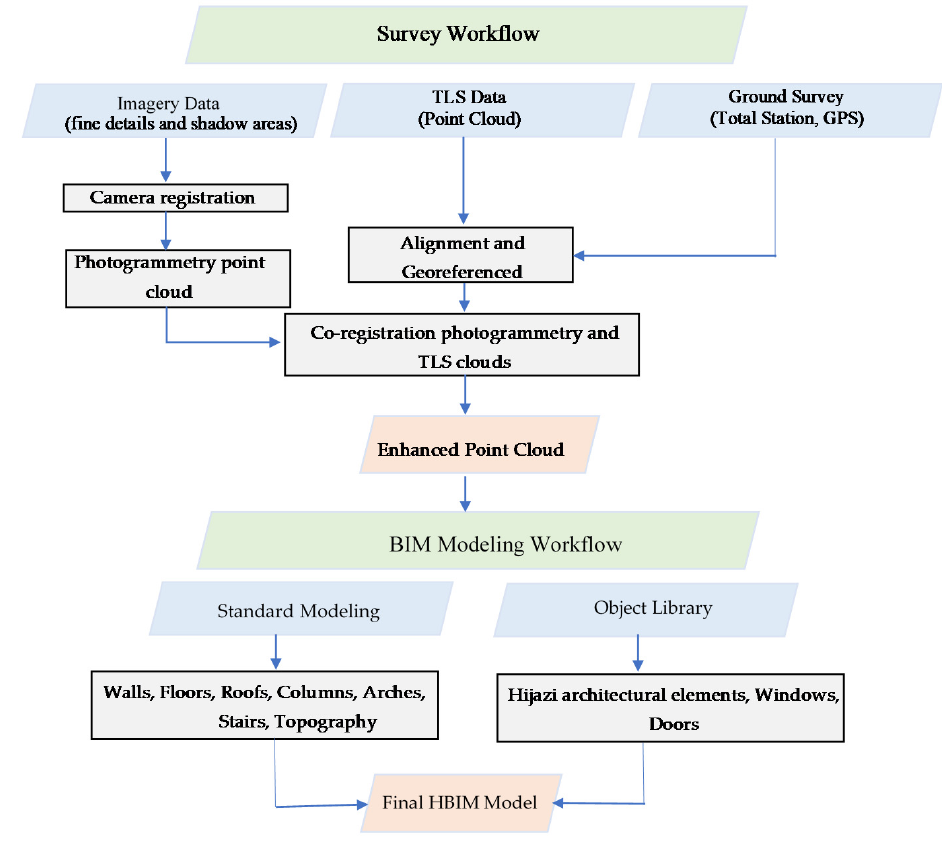
Figure 1. Scan-to-BIM workflow.